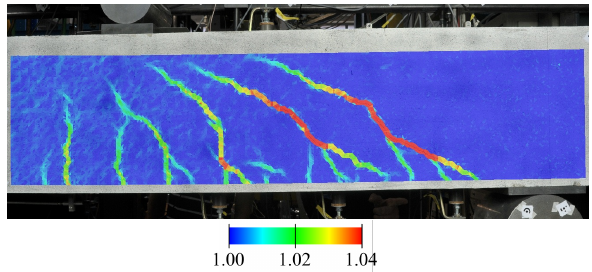
Figure 3. Color-coded visualization of the principal strains on the right half of a concrete beam under